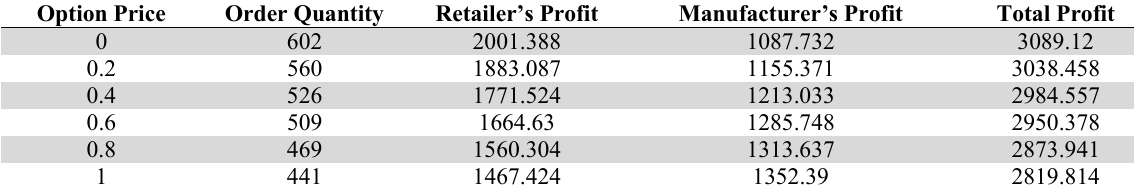
Effects of the option price on output of the model Option Price Order Quantity Retailer’s Profit Manufacturer’s Profit Total Profit 0